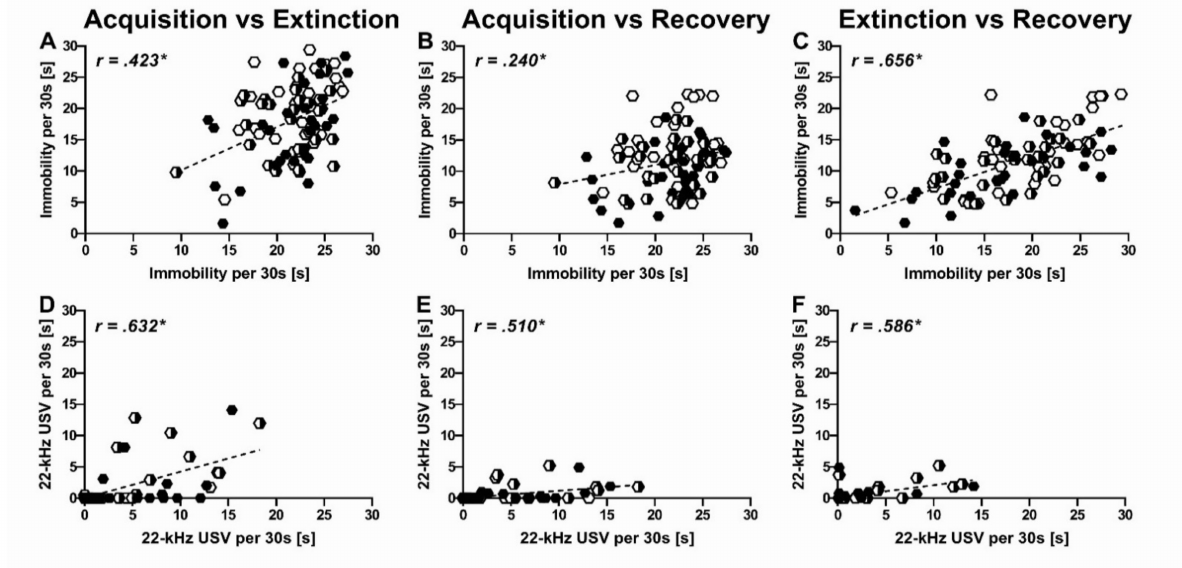
Figure 9. Correlation between immobility and 22-kHz USV emission. Duration of immobility ( A–C ) and 22-kHz USV ( D–F ) during acquisition in relation to extinction ( A,D ) and recovery ( B,E ), and during extinction and recovery ( C,F ), respectively, with individual values for SERT +/+ (black diamond), SERT +/ − (black-white diamond), and SERT − / − (white diamond) rats. N = 29 SERT +/+ (15 female, 14 male), 30 SERT +/ − (15 female, 15 male), 28 SERT − / − (14 female, 14 male) rats. Statistical significance ( p < 0.05) of correlation coefficients is indicated in bold and